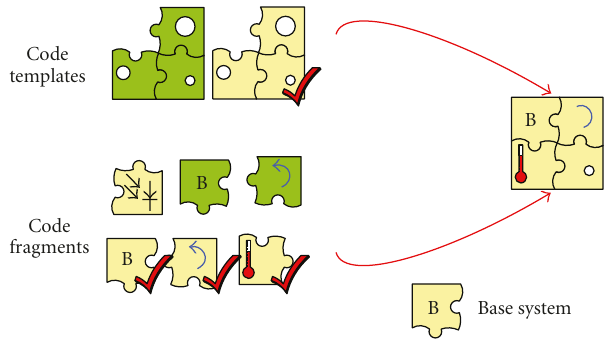
Figure 8: Code selection and